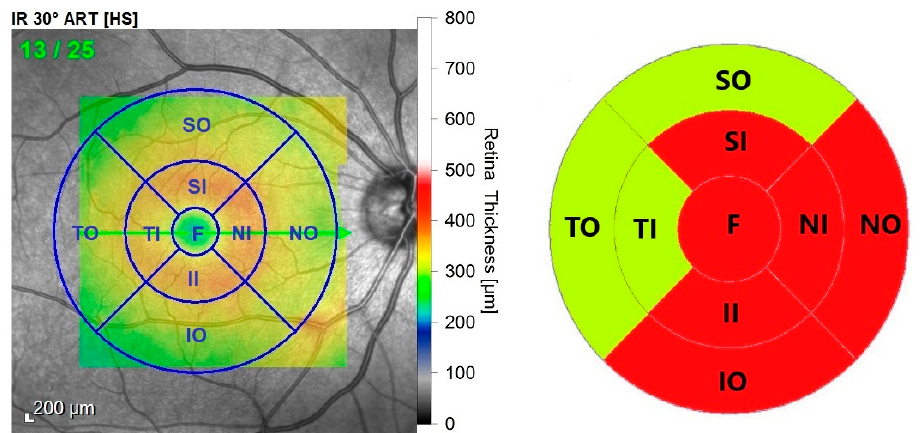
Figure 3. Predominant DME pattern in the retinal sectors of the right eye (images from our study). Abbreviations: F—fovea, SI—superior inner, NI—nasal inner, II—inferior inner, TI—temporal inner, SO—superior outer, NO—nasal outer, IO—inferior outer, TO—temporal outer. A statistically significant correlation between the clinical and OCT patterns of DME and the severity of DR, CMT, and BCVA was proved [20,21].